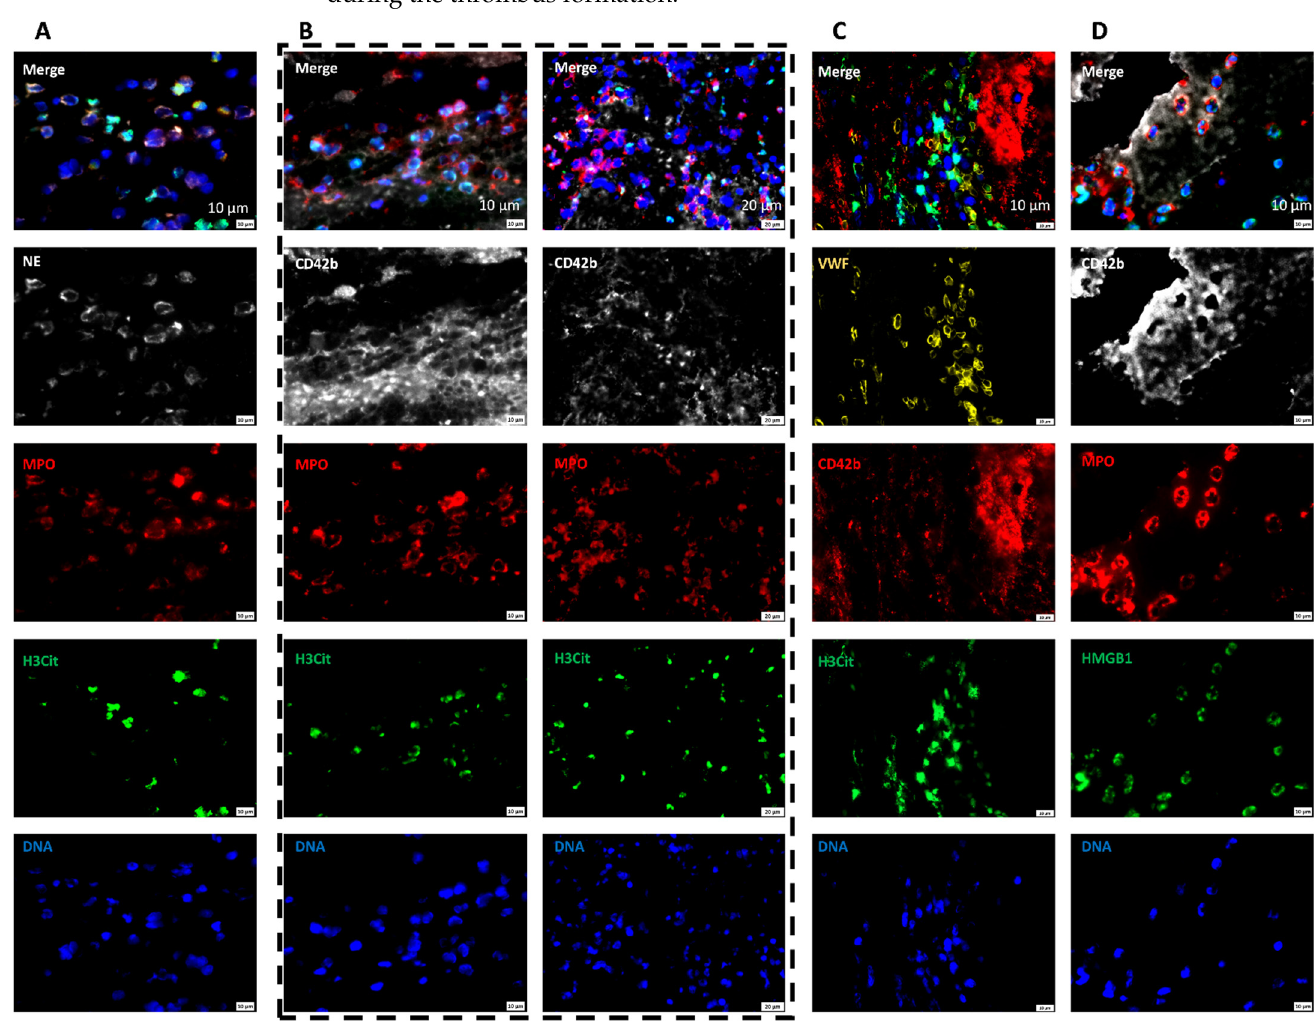
Figure 9. Platelet-rich areas show a close association between neutrophil-specific and platelet-specific components. ( A ) Representative ischemic stroke patient thrombi stained for neutrophils (MPO, red and NE, white), NETs (H3Cit, green), and DNA (DAPI, blue). Scale bars: 10 µ m. ( B ) Two representative ischemic stroke patient thrombi stained for platelets (CD42b, white), neutrophils (MPO, red), NETs (H3Cit, green), and DNA (DAPI, blue). Platelets are seen in close association with NETs. Scale bars: 10 µ m, left panel; 20 µ m, right panel. ( C ) Representative ischemic stroke patient thrombi stained for von Willebrand factor (VWF, violet), platelets (CD42b, red), NETs (H3Cit, green), and DNA (DAPI, blue). Von Willebrand factor is seen at the interface with platelets in NET-rich areas. Scale bars: 10 µ m ( D ) Representative ischemic stroke patient thrombi stained for platelets (CD42b, white), HMGB1 (green), neutrophils (MPO, red), and DNA (DAPI, blue). HMGB1 is visible interspersed between platelets and neutrophils. Scale bars: 10 µ